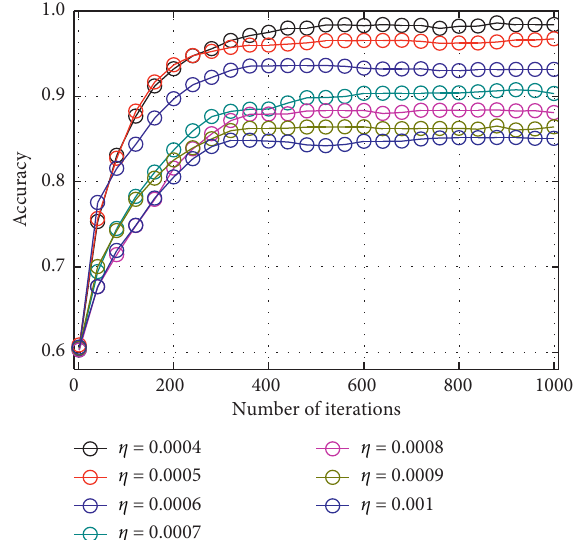
Figure 7: Comparison of recognition accuracy of different learning rates.